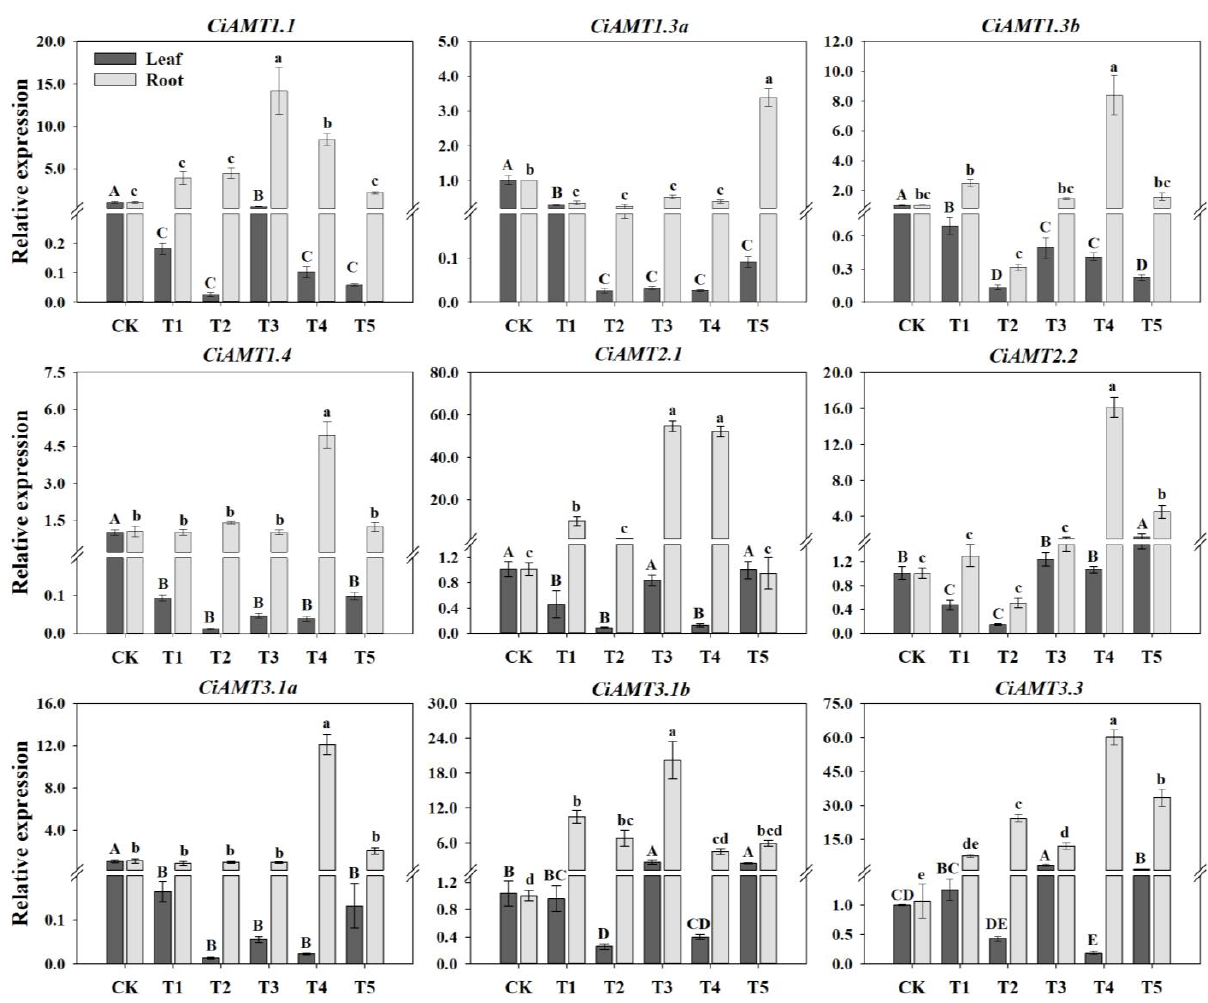
Figure 5. Relative expression of pecan CiAMT genes under varying NH 4+ :NO 3 − ratios. The expres- sion levels of CiAMT in pecan leaves and roots after varying NH 4+ :NO 3 − ratio treatments were quantified by qRT-PCR, with Actin as the reference gene. Different capital letters indicate significant differences in leaves ( p < 0.05), and different lowercase letters indicate significant differences in roots ( p < 0.05).